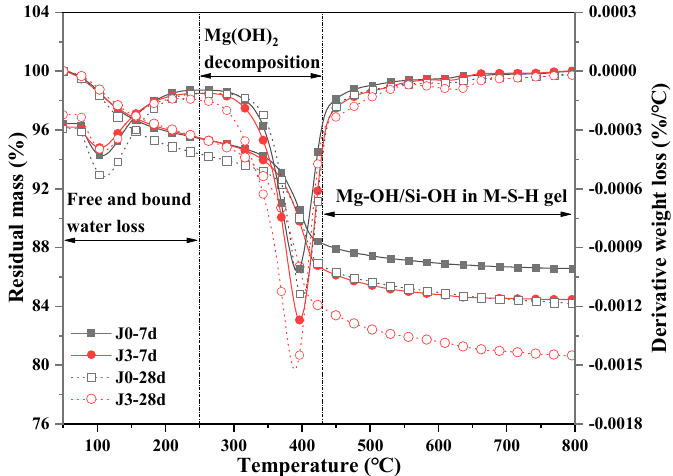
Figure 11. TG and DTG curves of M-S-H cement with SRA under dry conditions.